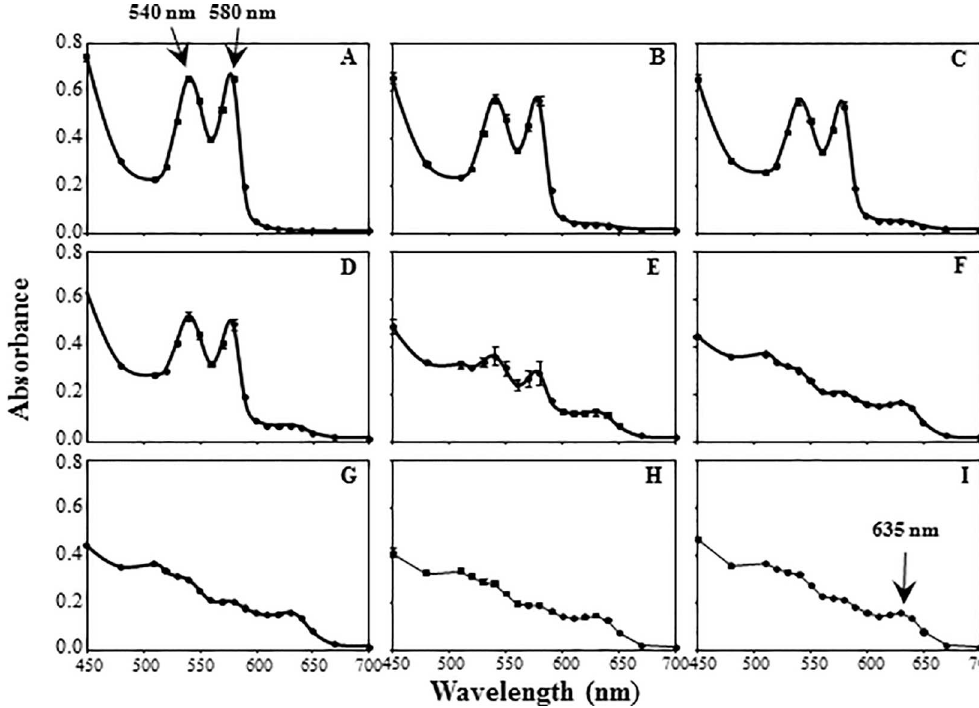
Fig 1. Representative spectral scan of lysed blood cells with increasing concentrations of sodium nitrite. (A) 0 mM, (B) 6 mM, (C) 12 mM, (D) 15 mM, (E) 19 mM, (F) 25 mM, (G) 29 mM, (H) 58 mM, (I) 102 mM of sodium nitrite was added to blood aliquots, lysed, and added to 96 well plates in triplicate. Optical density was measured from 400 nm to 700 nm for each well. Arrows point to the hemoglobin peaks at 540 and 580 nm and a methemoglobin peak at 635 nm. Error bars correspond to the standarderrors of the means.